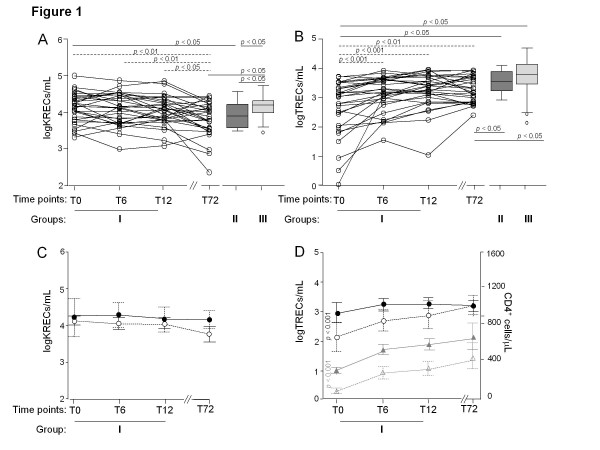
Quantification of KRECs and TRECs. (A) Number of KREC+ lymphocytes in 36 HIV-1+ patients that initiated cART and were thereafter followed up for 72 months (group I, from T0 to T72), in 22 HIV-1+ patients that did not need therapy (group II), and in 72 age and gender-matched uninfected subjects (group III). (B) Number of TREC+ lymphocytes in group I, II and III. Values in individual patients are shown as clear circles, and dashed significance lines indicate the results of the longitudinal analysis. (C) KRECs and (D) TRECs and CD4+ cell modulation during the follow-up in HIV-1+ patients of group I divided according to their CD4+ cell number before therapy start (< 200/μL: clear symbols, dashed lines; and ≥ 200/μL: filled symbols, solid lines). The lines (in gray for CD4+ cells) connect the means (indicated either by circles, as in the case of KRECs and TRECs, or by triangles, as in the case of CD4+ cells); error bars indicate the 95% confidence intervals.